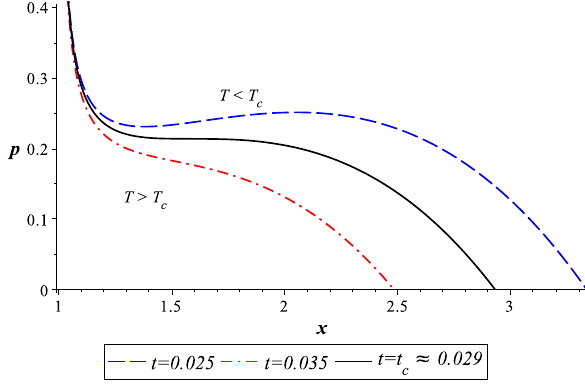
Fig. 1 p − x diagram for the radiation case ω = 1 / 3. Here V ∝ r − 1